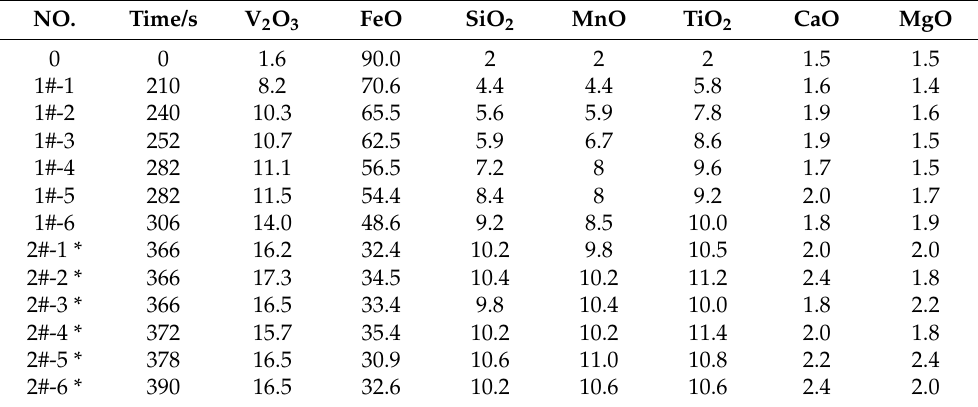
Table 4. Slag compositions (wt%) in various time during industrial